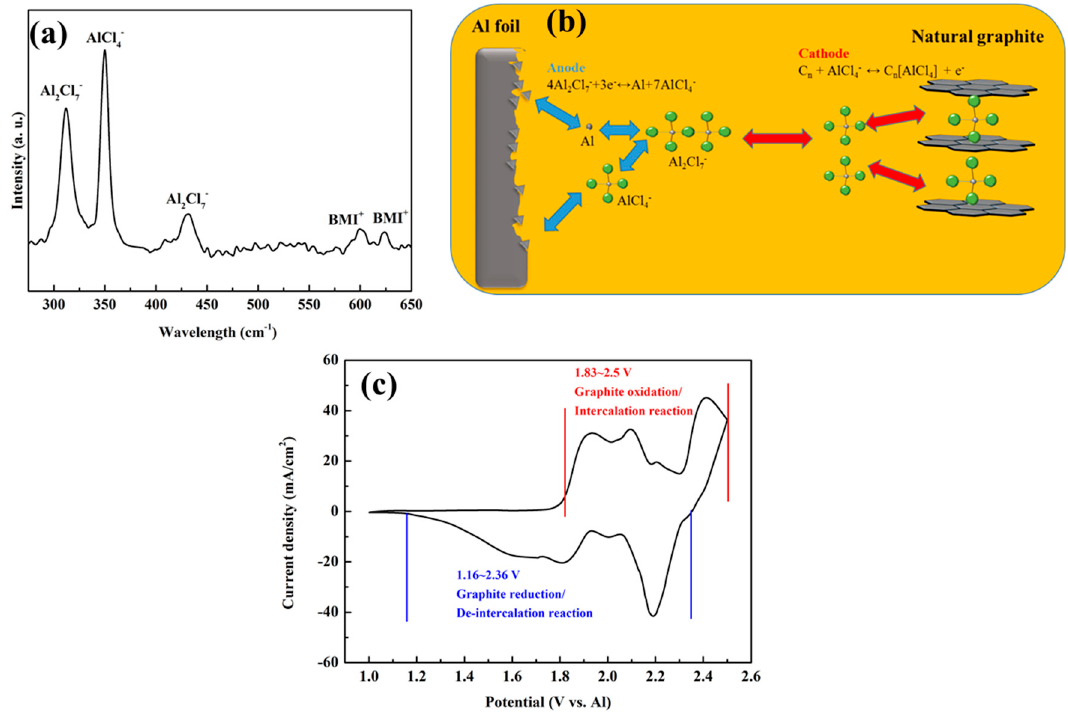
Figure 2. ( a ) AlCl 3 /[BMIm]Cl electrolyte Raman spectra; ( b ) schematics of the Al battery charging–discharging process; and ( c ) cyclic voltammetry (CV) curve at 1 mV/s.